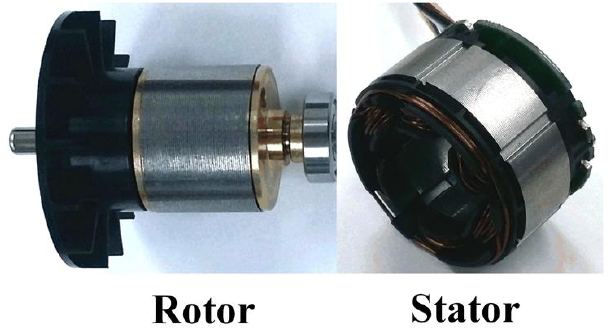
Figure 1. The actual model used for the equivalent magnetic circuit analysis.